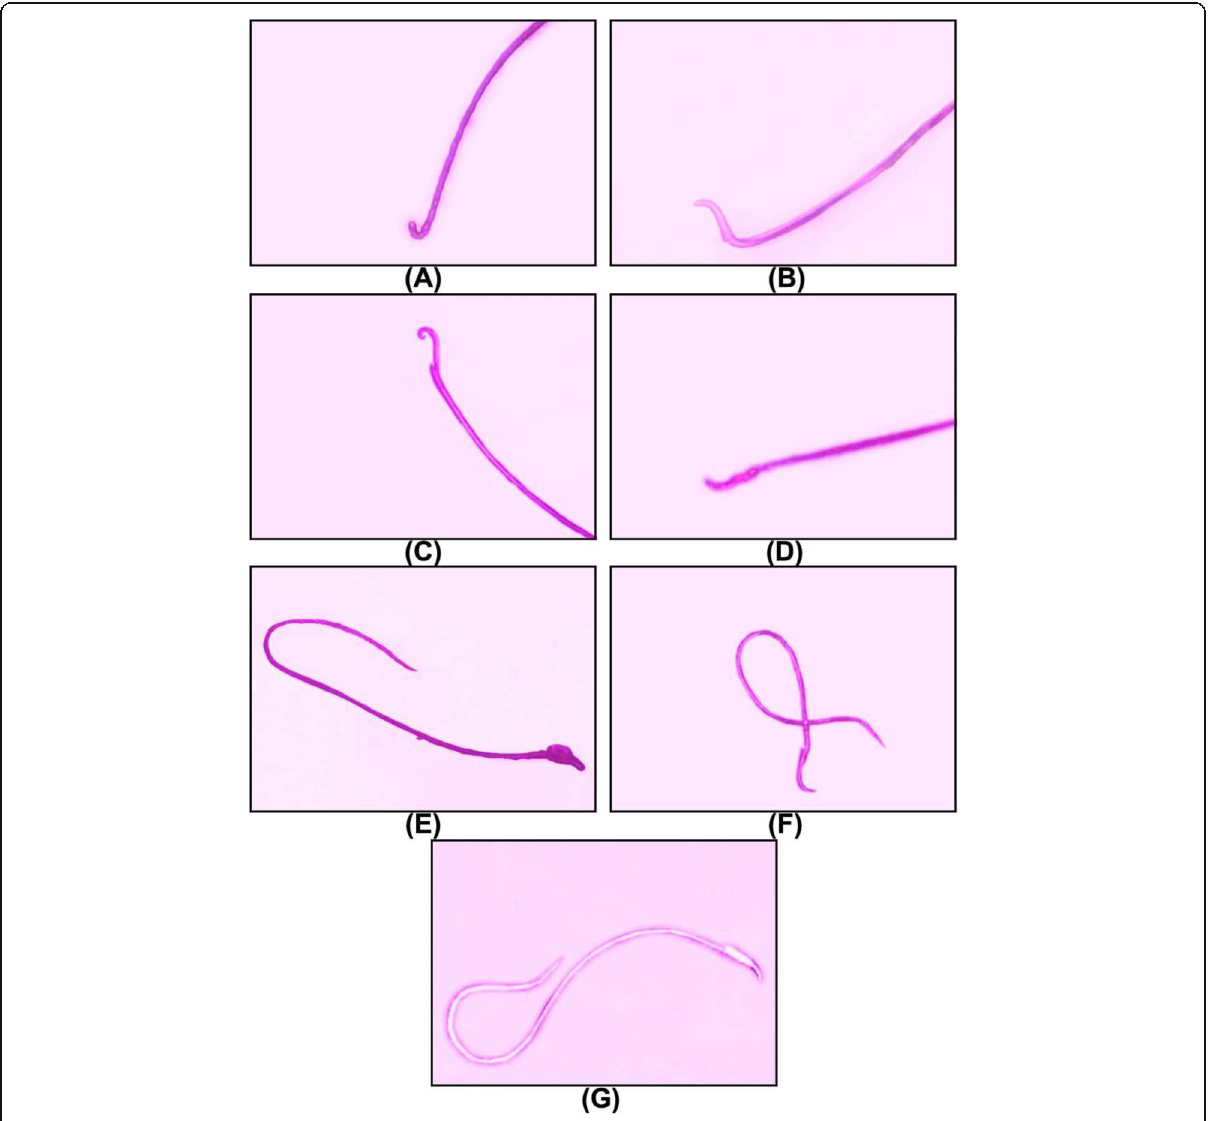
Fig. 4 Photomicrograph of different sperm abnormalities of rats fed with grilled Mugil cephalus fish showing a vacuolated head, b hookless head, c acute curvature head, d deformed orientation head, e triangular head with coiled tail, f quasi-normal head with coiled tail, and g banana-shaped head with coiled tail (E&N